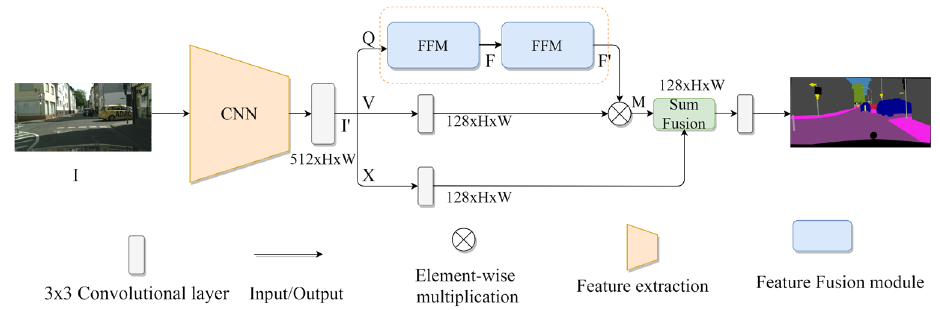
Figure 1. The overall structure of our